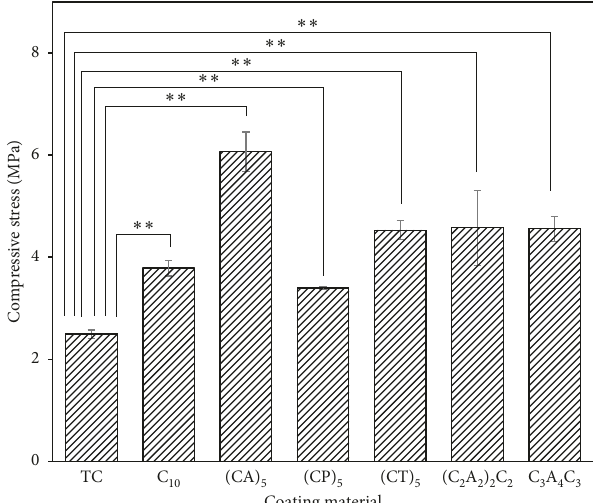
Figure 2: Effect of coating material to the compressive stress of the